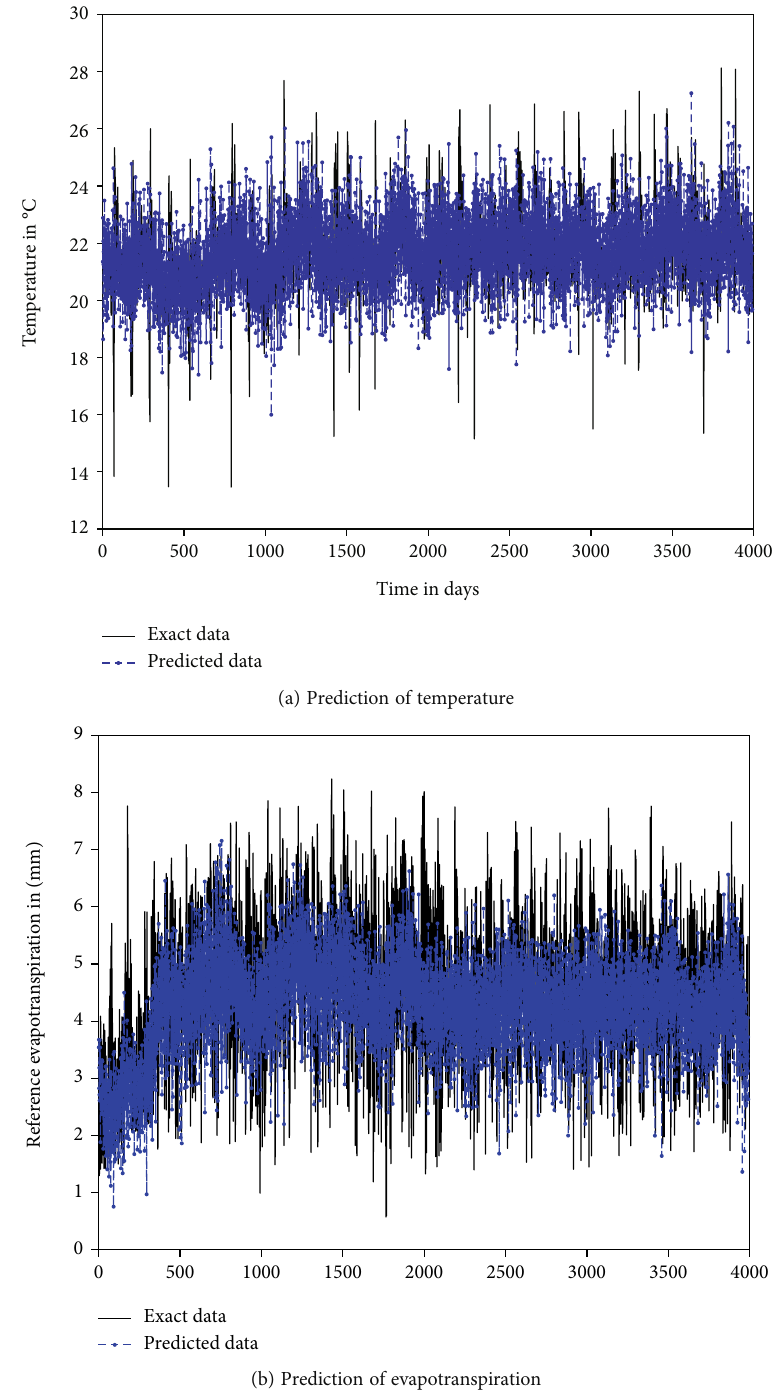
Figure 12: Prediction of weather